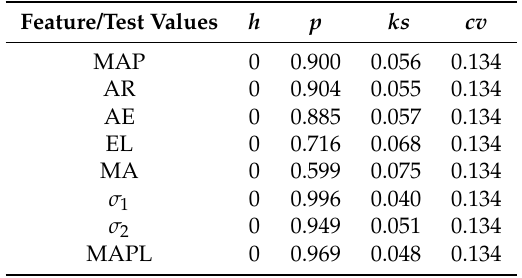
Table 2. The hypothesis h values are represented from the artificial feature using the bootstrap approach with the number of replications ( N = 100), where p is the p -value, ks denotes the statistical value of the Kolmogorov-Smirnov test, and cv is the threshold value. Other features show similar results. Feature/Test Values h p ks cv